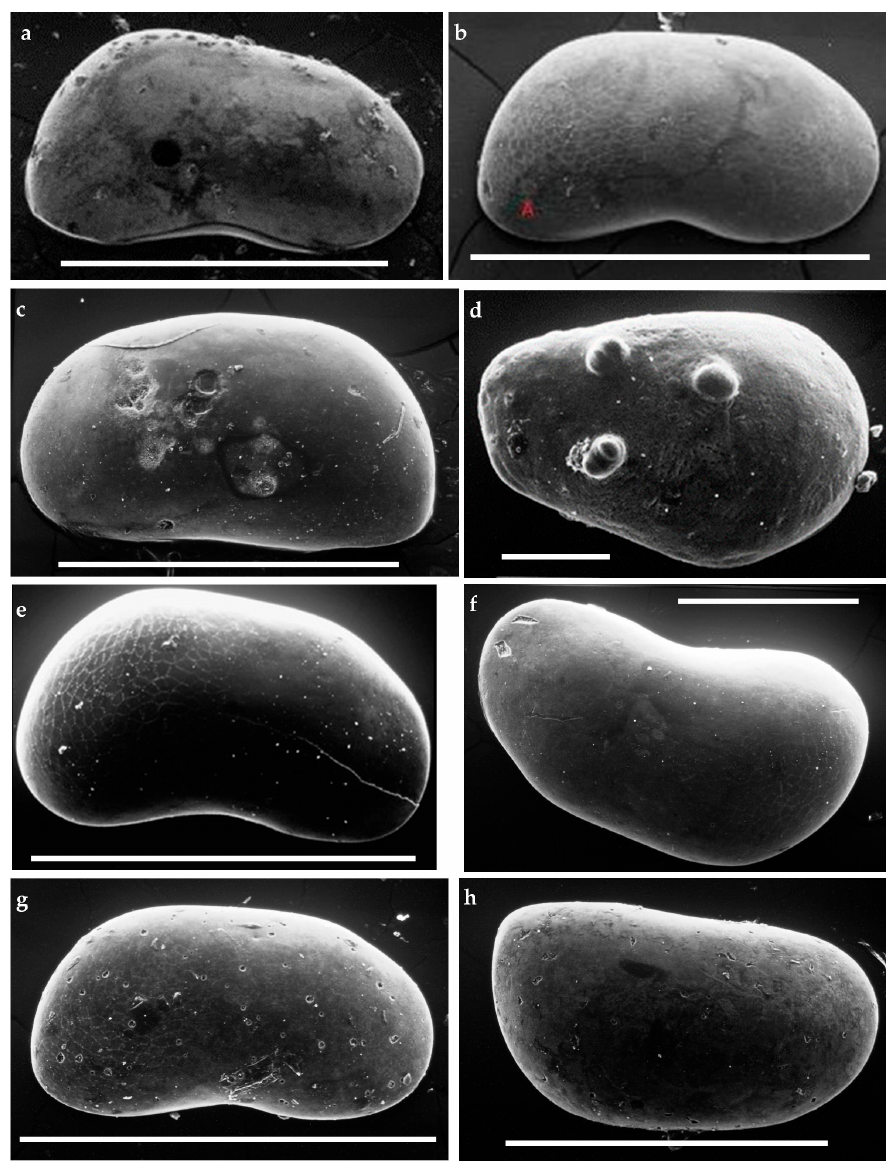
Figure 4. Scanning Electron Microscope microphotos of Cava Nuova ostracods, also showing microboring. ( a ) Caspiocypris basilicii Spadi and Gliozzi 2018, lateral view of right female valve, scale bar 1 mm. ( b ) Caspiocypris tuderis Spadi and Gliozzi 2018, lateral view of right female valve, scale bar 1mm. ( c ) Caspiocypris tiberina Spadi and Gliozzi 2018, lateral view of left female valve, scale bar 1 mm. ( d ) Cytherissa lacustris Sars 1863, lateral view of left valve, scale bar 200 µ m. ( e ) Caspiocypris basilicii Spadi and Gliozzi 2018, lateral view of right female valve, scale bar 1 mm. ( f ) Caspiocypris basilicii juvenile right valve, scale bar 500 µ m. ( g ) Caspiocypris tuderis Spadi and Gliozzi 2018, lateral view of right female valve, scale bar 1 mm. ( h ) Caspiocypris tiberina Spadi and Gliozzi 2018, lateral view of left female valve, scale bar 1 mm.